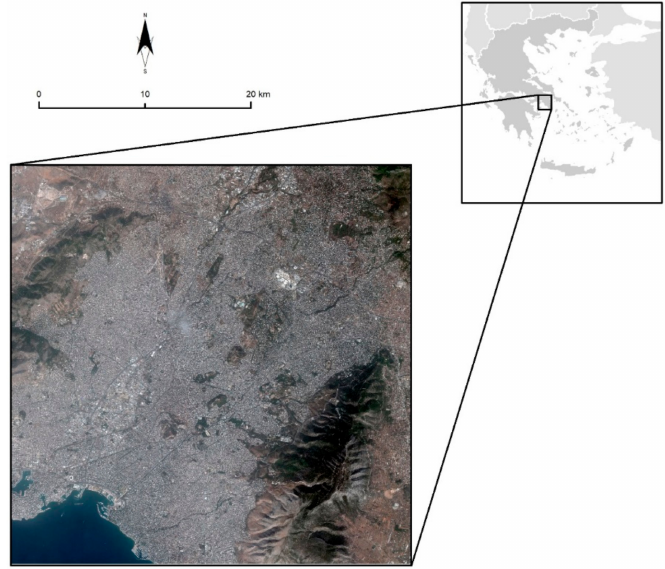
Figure 2. The study area in Athens by Pleiades 1B multispectral